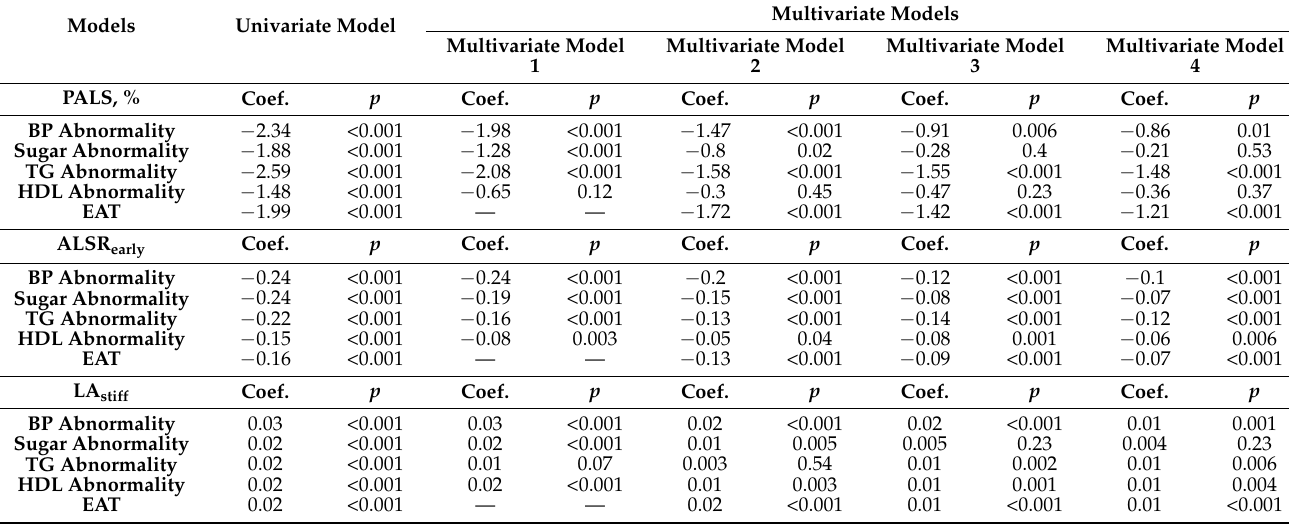
Table 6. Multivariate linear regression analysis on associations of metabolic components or epicardial fat thickness (EAT) with LA diastolic/deformation parameters as dependent